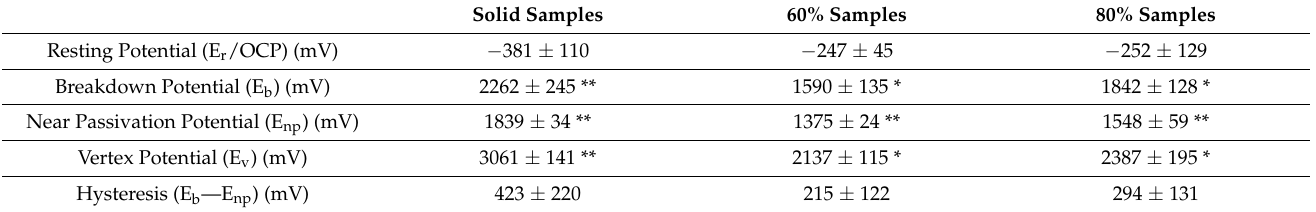
Table 4. Cyclic potentiodynamic polarisation landmark summary—mean values and standard deviation for each landmark. ** Denotes statistical significance to both groups ( p < 0.05). * Denotes statistical significance to solid samples ( p < 0.05) (one-way ANOVA,